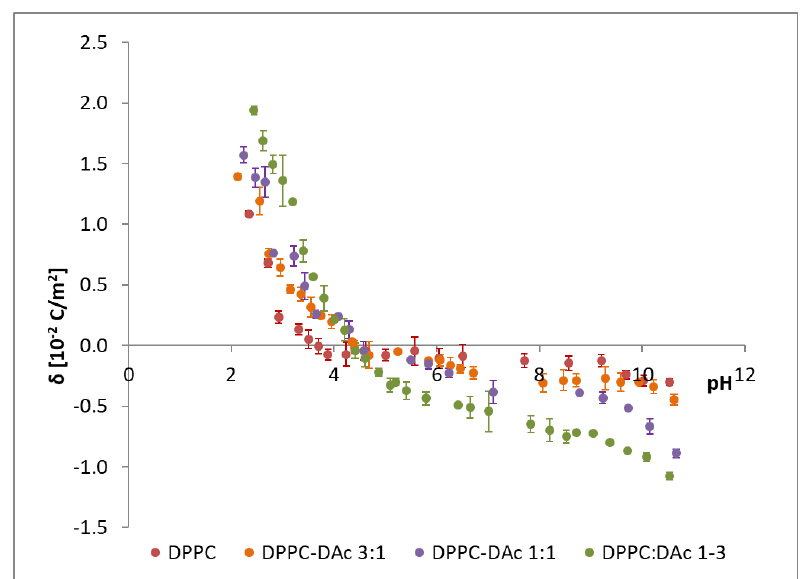
Figure 8. Dependence of DPPC and DPPC: the Dio membrane surface charge densities vs. the pH of the electrolyte solution.